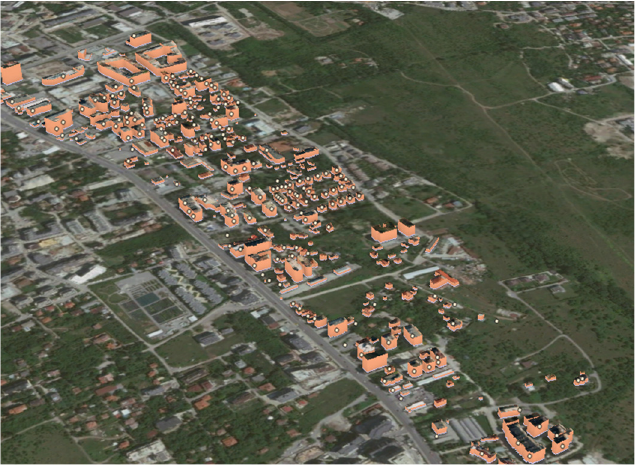
Figure 11. The CityGML model in ArcGIS Pro.